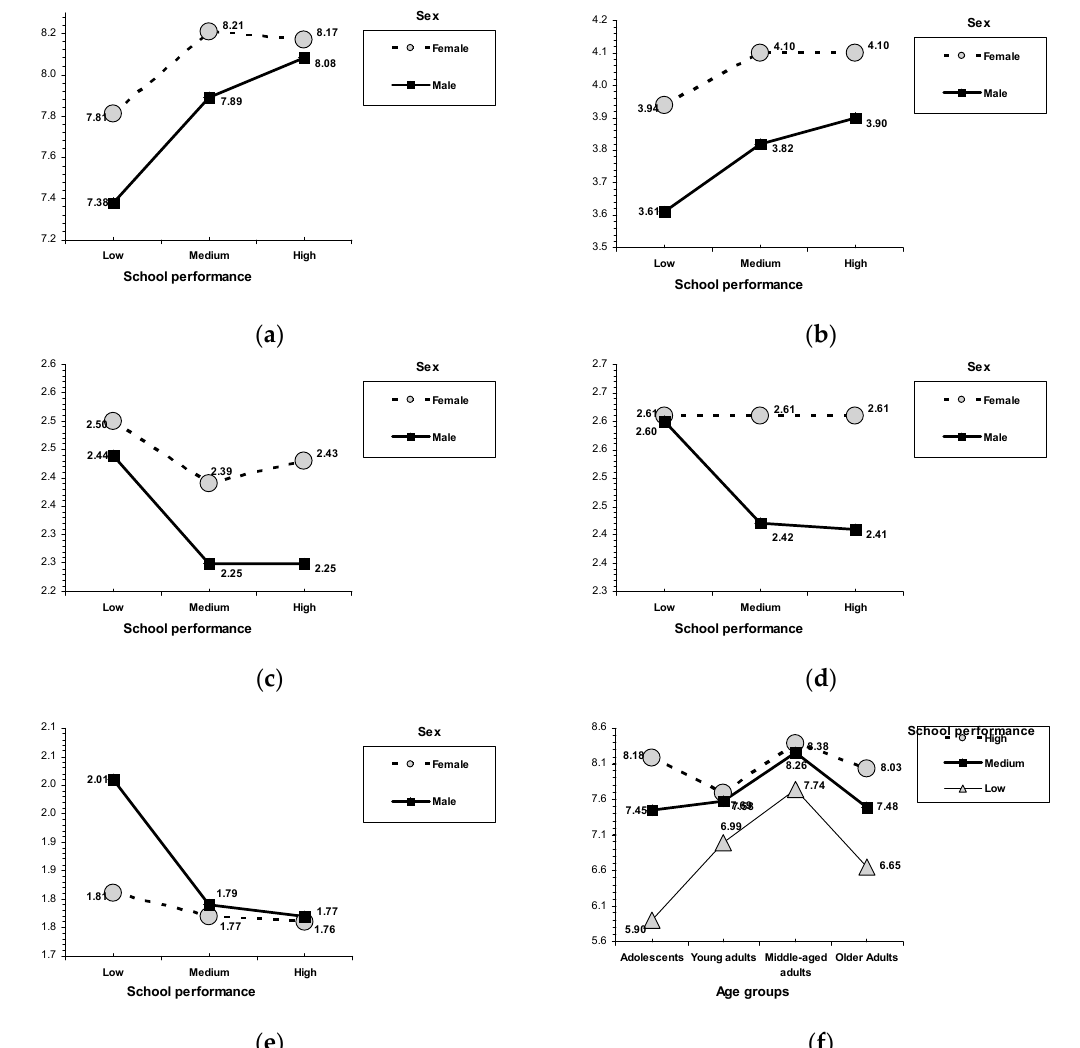
Figure 2. Interactions for school performance and sex. ( a ) Family self-esteem, ( b ) empathy, ( c ) nervousness, ( d ) emotional instability, and ( e ) hostility. Interactions for school performance and age. ( f ) Academic/ professional self-esteem.